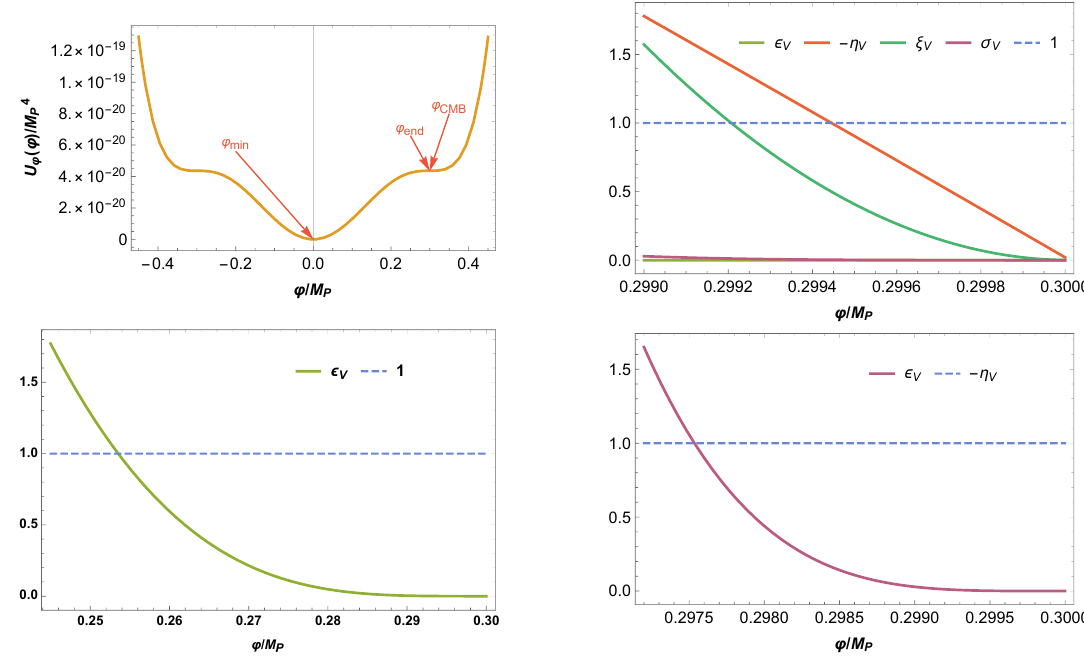
Figure 2. In the top-left panel, normalised inflaton-potential of Model II as a function of ‘ ϕ/ M P ’ for benchmark value mentioned in table 3. In the top-right panel, absolute values of four slow roll parameters ( (cid:15) ) are plotted with ϕ/ M as variable. Left and righ panel of the second V , − η V , ξ V , σ V P row displays (cid:15) and σ respectively against ϕ/ M for benchmark values mentioned in table 3. V V P The dashed line indicates 1 . These graphs show that | (cid:15) 1 during the V | < | σ V | < | ξ V | < | η V | < slow-roll inflation, similar to what we have obtained in Model